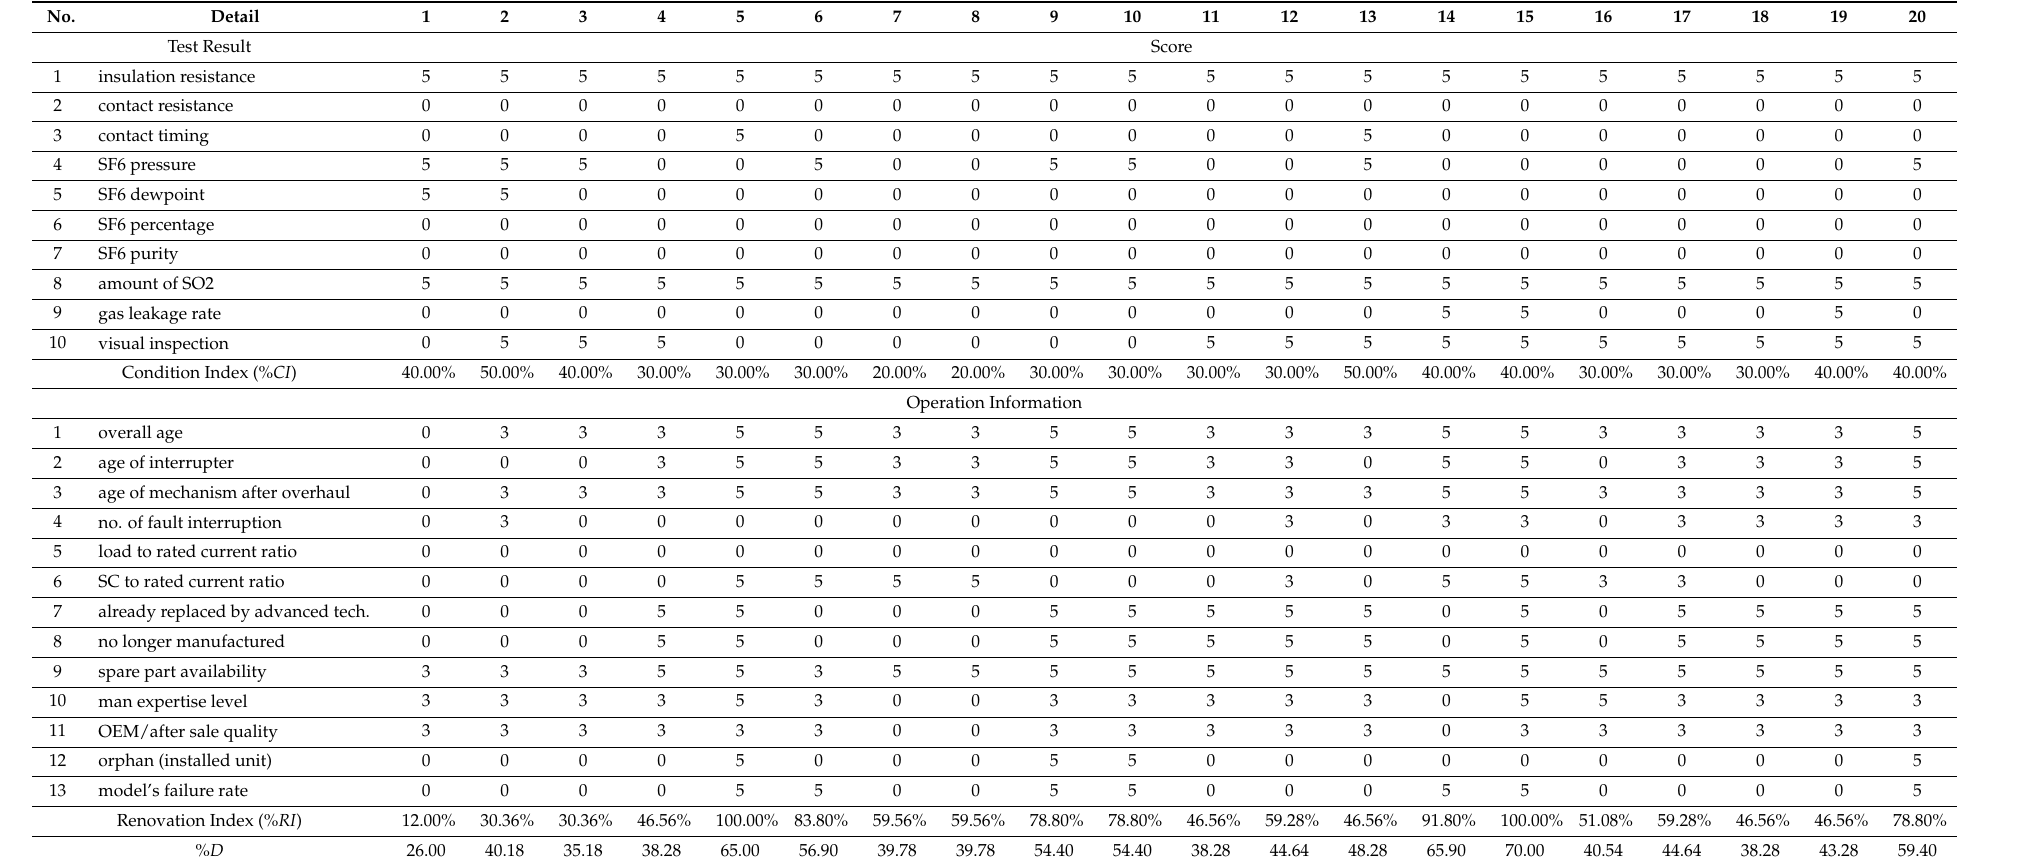
Table 13. Scores and evaluation results of the % CI , % RI , and D-distance of twenty 115 kV HV circuit